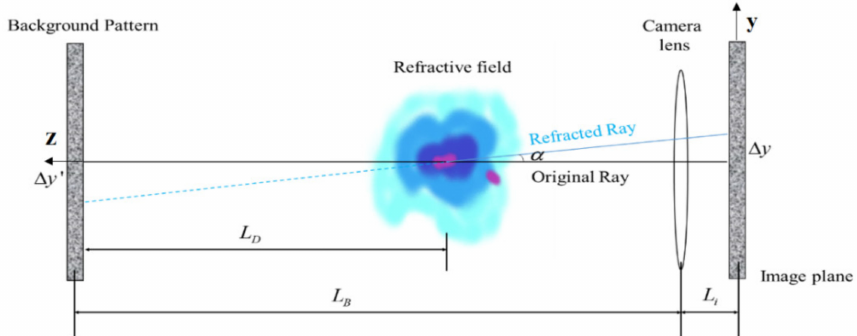
Figure 1. Simplified model of light deflection in the refractive index field in a background-oriented schlieren setting. Black solid line: optical path without refractive index field. Blue solid line: light path with refraction field. The blue dotted line represents the virtual path of the